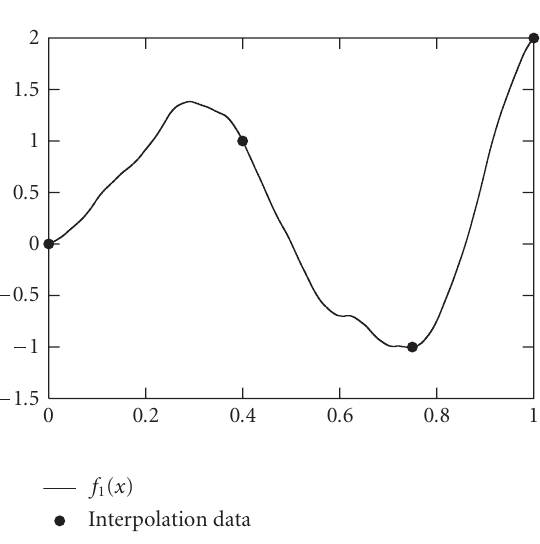
F 2 1 ( x , z ) = − 0 . 08 z +11 . 882 x 3 − 17 . 522 x 2 +4 . 8 x +3 . 24 Figure 5.5 F 2 3 ( x , y ) = − 0 . 025 z +5 . 6159 x 3 − 8 . 0068 x 2 − 0 . 5591 x +8 . 075 F 2 1 ( x , z ) = 0 . 048 z +16 . 9824 x 3 − 23 . 4544 x 2 +3 . 52 x − 6 . 664 Figure 5.6 F 2 2 ( x , z ) = 0 . 0429 z − 52 . 7327 x 3 +65 . 5487 x 2 +6 . 2269 x − 9 . 6999 F 2 3 ( x , z ) = 0 . 025 z +19 . 0457 x 3 − 20 . 8914 x 2 − 15 . 1293 x +9 . 175 F 2 1 ( x , z ) = 0 . 048 z +3 . 6899 x 3 − 0 . 7521 x 2 − 4 . 0339 x +2 . 856 Figure 5.7 F 2 2 ( x , z ) = 0 . 0429 z − 5 . 9516 x 3 +7 . 7897 x 2 +4 . 0761 x +1 . 8714 F 2 3 ( x , z ) = 0 . 025 z +1 . 5994 x 3 − 5 . 2041 x 2 +0 . 5547 x +7 . 925 F 2 1 ( x , z ) = 0 . 128 z +1 . 446 x 3 − 1 . 246 x 2 +0 . 544 x Figure 5.8